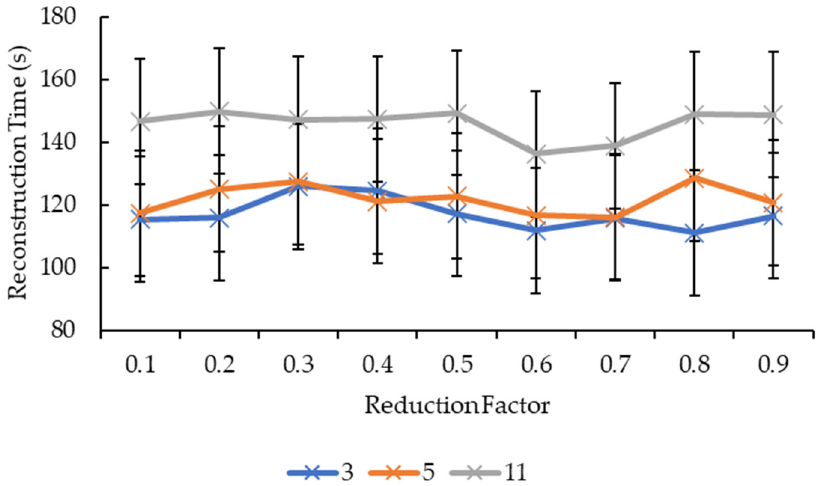
Figure 10. Graph of reconstruction time against reduction factor for convolution kernel Gaussian.